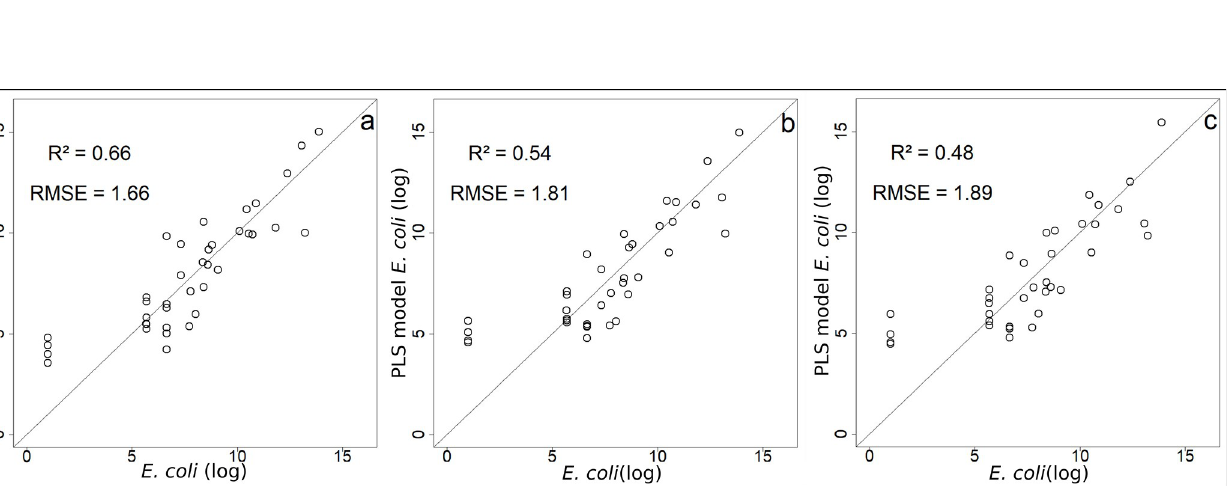
PLOS NeglectedTropical Diseases | https://doi.org/10.1371/journal.pntd.0009634 August 17, 2021 16 /